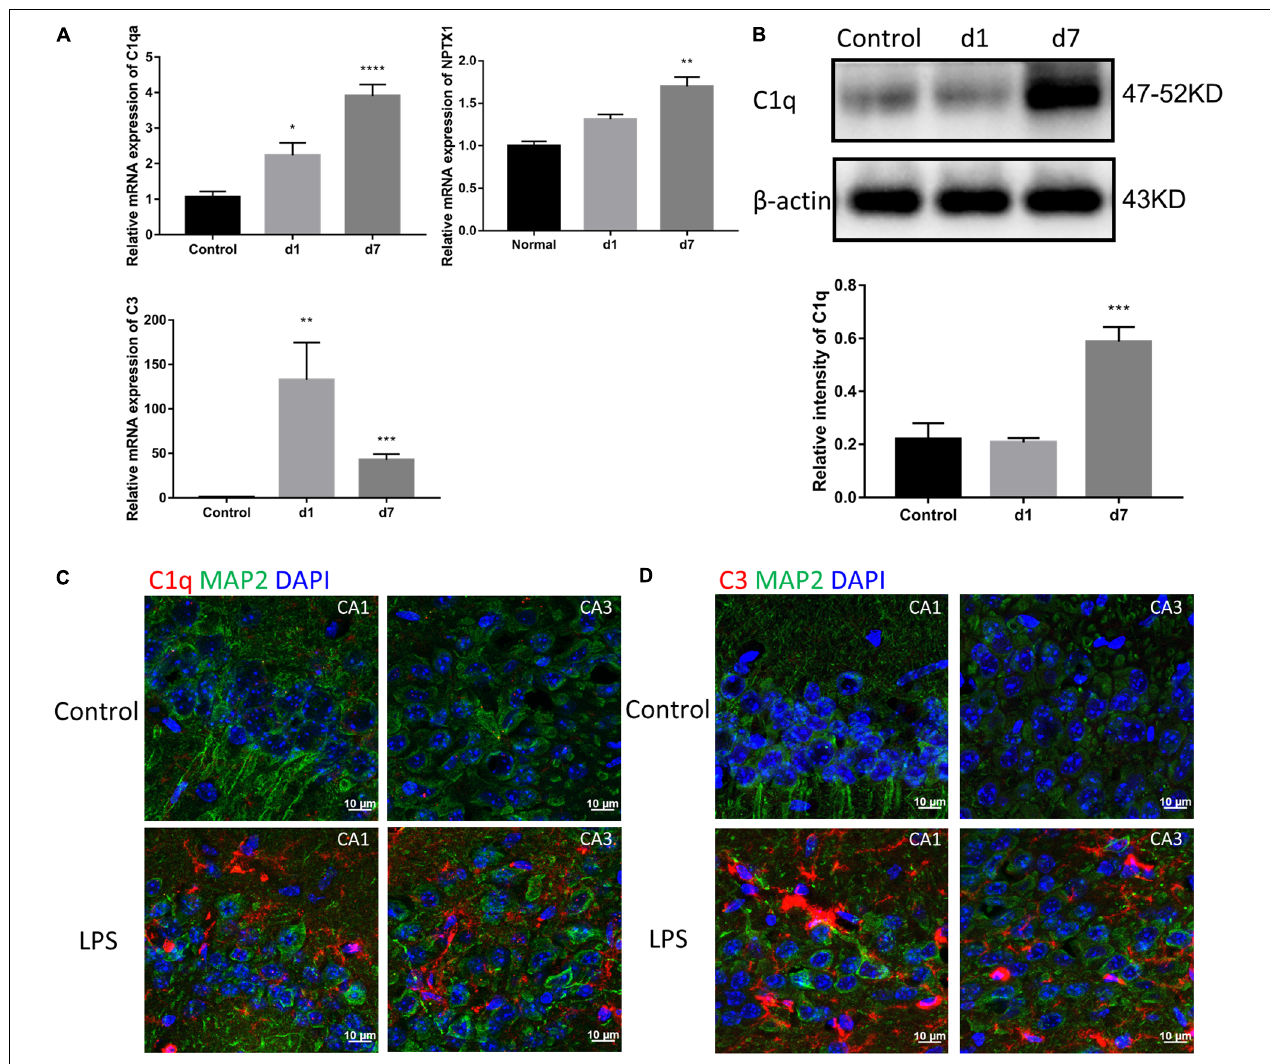
FIGURE 4 | Effects of LPS on the expression of complements in the brain. (A) The relative mRNA expression of C1qa, C3, and NPTX1 in the brains of the control mice and mice treated with LPS for 1 or 7 days were determined by qPCR assay. NPTX1 encodes neuronal pentraxin 1, which is a homogenous acute-phase protein synthesized in the brain. Data were presented as means ± SEM ( ∗ P < 0.05, ∗∗ P < 0.01, ∗∗∗ P < 0.001, ∗∗∗∗ P < 0.0001 vs. control, by one-way ANOVA, n = 6). (B) Relative protein levels of C1q were determined by Western blot. The intensity of the blots was calculated using Image J and data were presented as mean ± S.E.M. ( ∗∗∗ P < 0.001 vs. control, by one-way ANOVA, n = 4). (C,D) Immunostaining of C1q and C3, respectively, in both the hippocampal CA1 and CA3 regions. MAP2 was used as the neuron